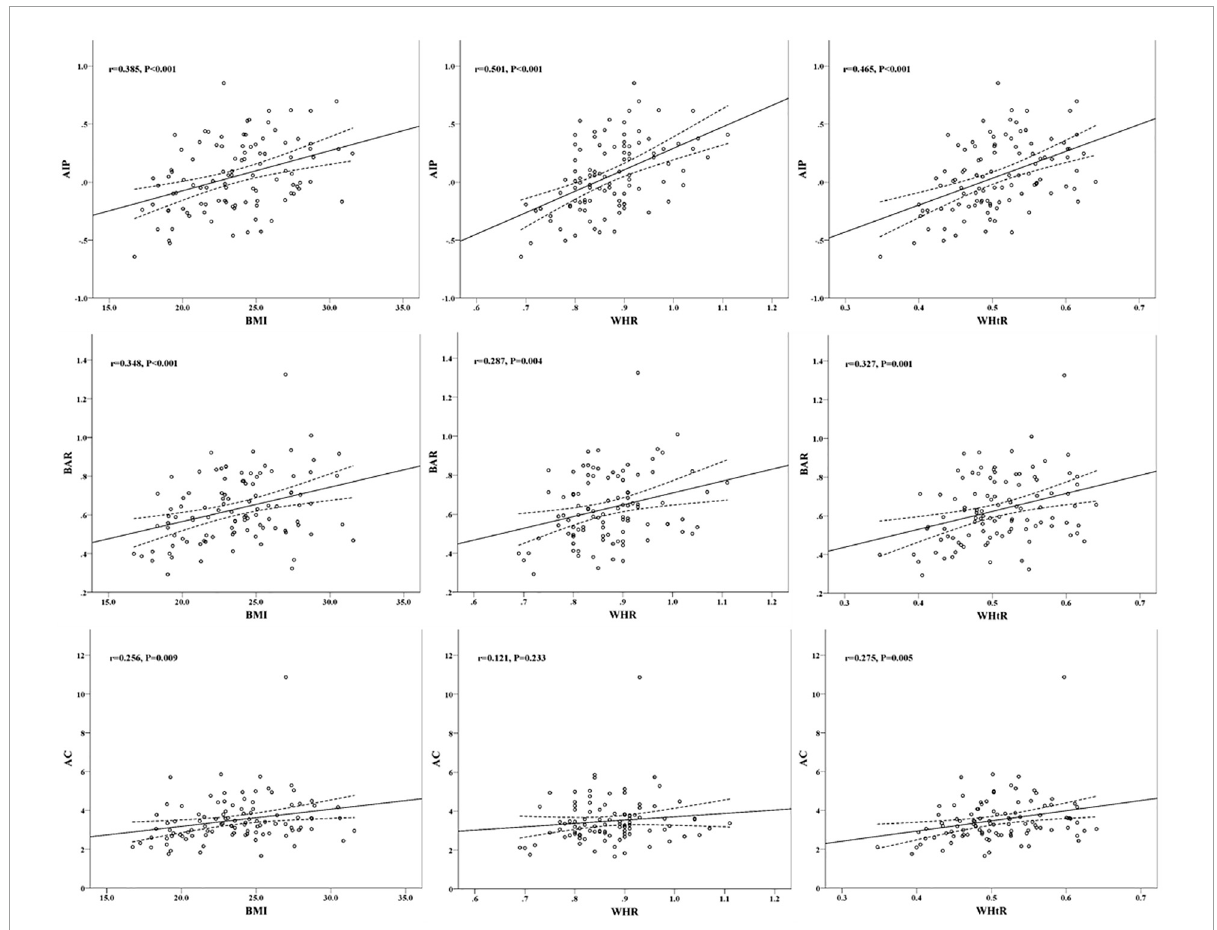
FIGURE2 Scatter plots of correlation between overweight and obesity indicators and cardiovascular risk predictors.